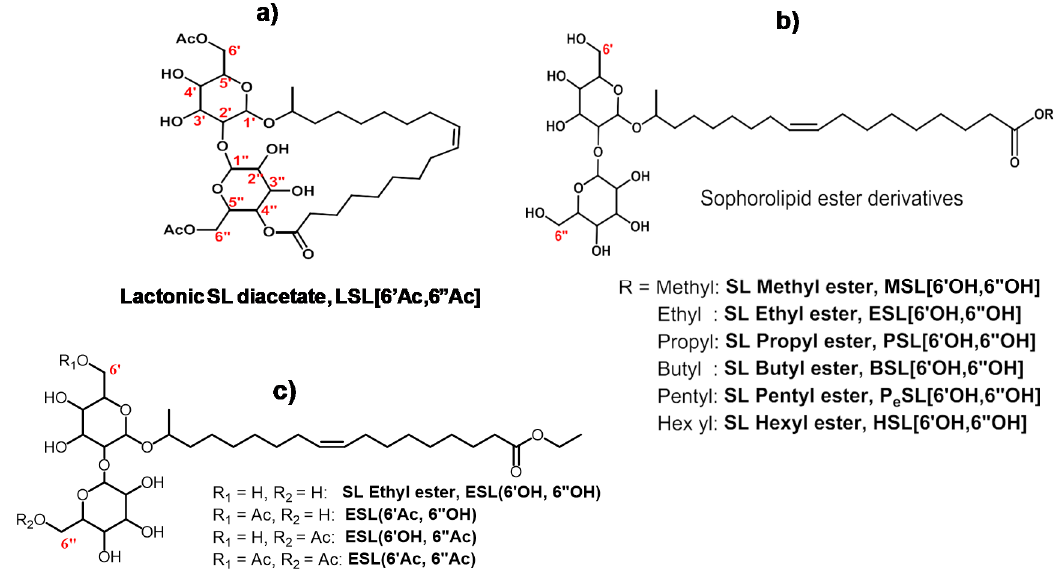
Figure 1. Chemical structures of ( a ) lactonic SL, ( b ) SL esters with increasing lengths, and ( c ) SL-ethyl ester with different degrees of acetylation.